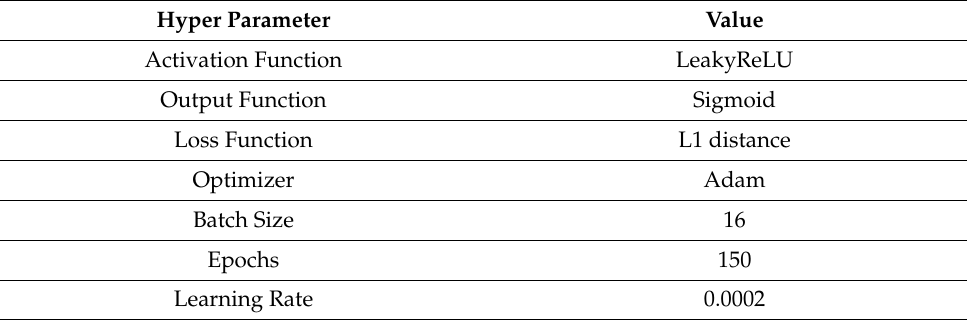
Table 1. Hyperparameter setting of the AE